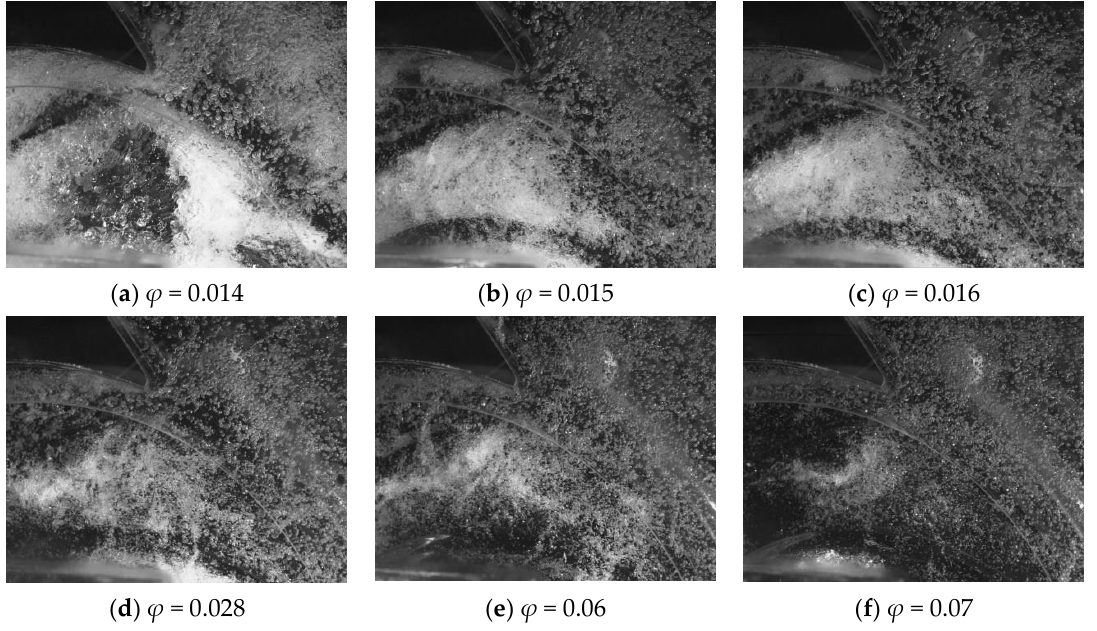
Figure 8. Flow behavior at different flowrate for α = 2% for a fixed rotor-stator position.